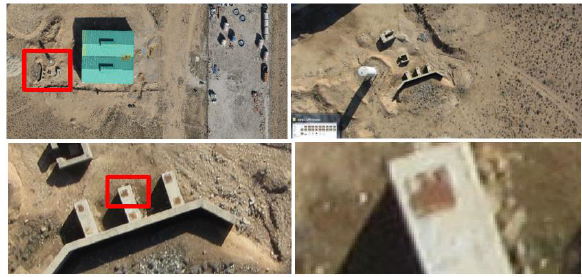
Figure 3: 2.5cm GSD of images taken from 80m flying height makes possible to produce high quality maps.